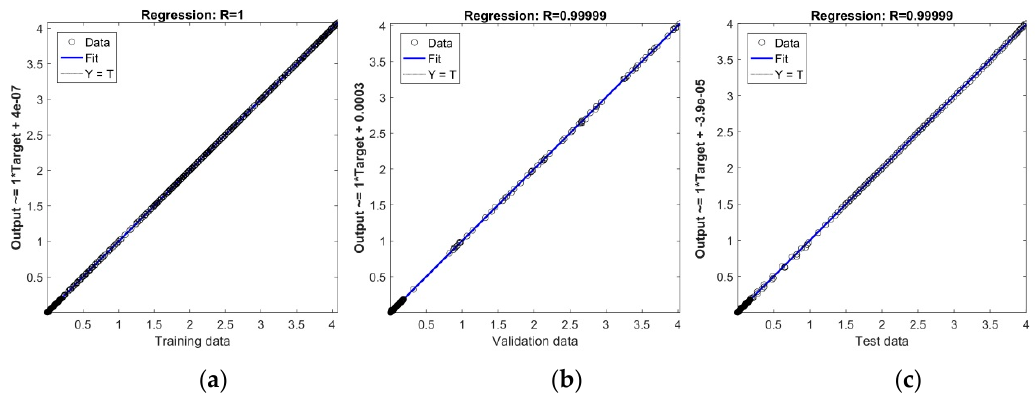
Figure 4. ( a ) Linear regression plot for training data; ( b ) Linear regression plot for validation data; ( c ) Linear regression plot for testing data.